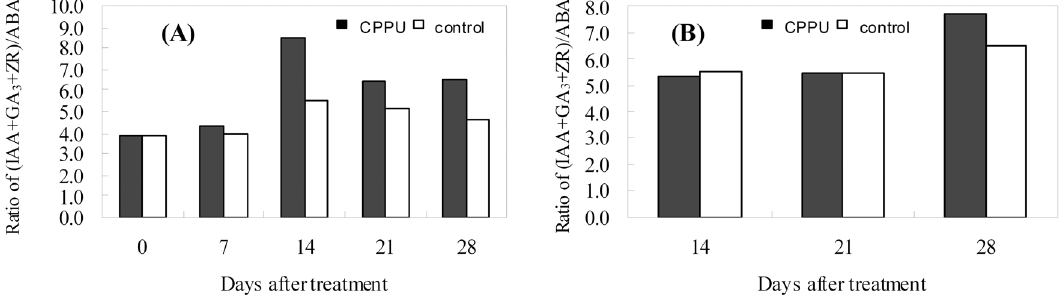
Fig 7. Changes in the ratio (IAA+GA 3 +ZR)/ABA in the husk (A) and seed (B) after CPPU